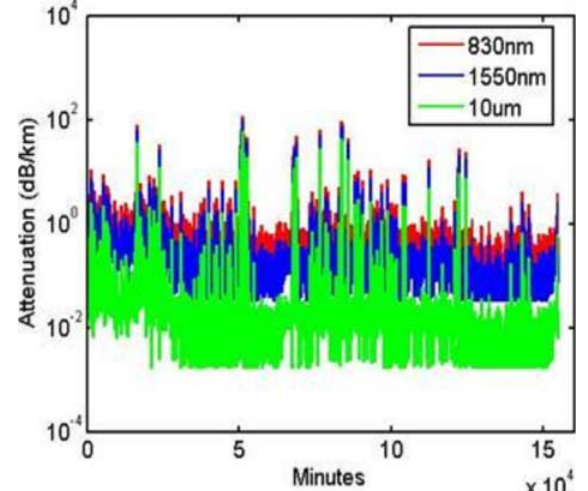
FIG. 14. TIME SERIES PLOT OF ESTIMATED SPECIFIC OPTICAL ATTENUATION BY KRUSE MODEL FOR 3 YEAR AND 4 MONTHS